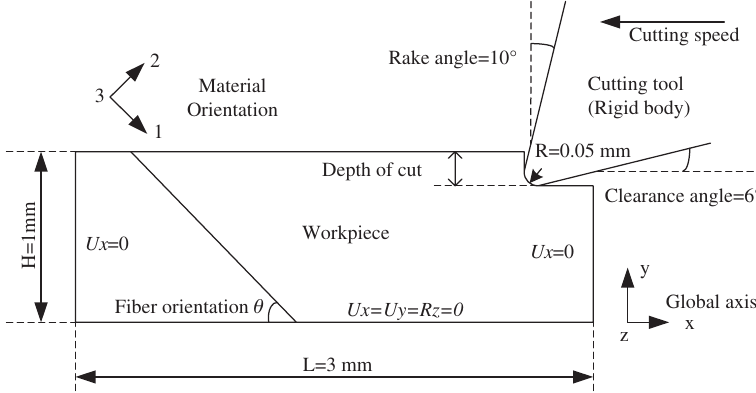
Figure 1: Orthogonal machining of fiber-reinforced polymer composites